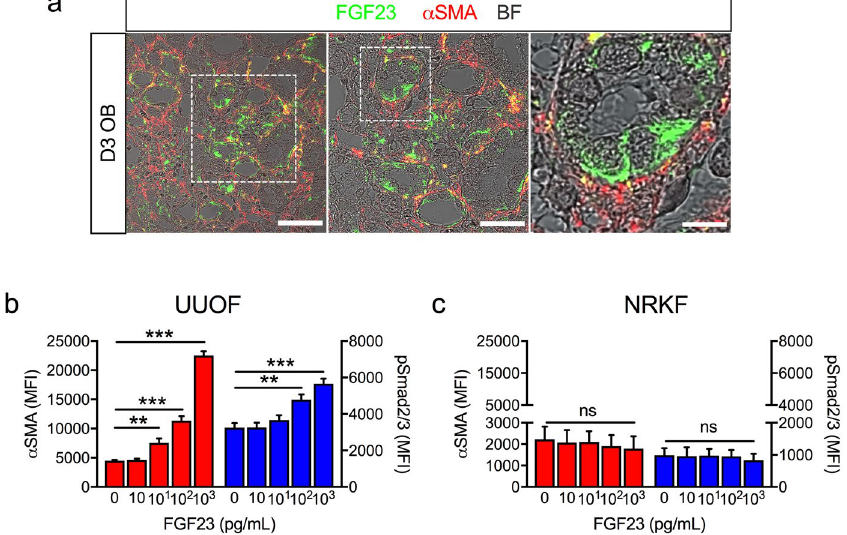
Figure 5. FGF23 stimulates renal fibroblast activation. ( a ) Representative immunofluorescent staining of FGF23 (green) and α SMA (red) in D3 OB kidney sections using brightfield (BF) confocal microscopy. Boxed region is enlarged in adjacent panels. Scale bars = 50, 25, 10 μ m left to right. ( b , c ) Quantitative flow cytometric analysis of FGF23 dose-related changes in α SMA (red) and phosphorylated Smad2/3 (blue) staining (mean fluorescence intensity, MFI) in UUOF ( b ) and NRKF ( c ) after 48 h treatment (n = 4 independent experiments). Data are shown as mean ± SD and represent at least three independent experiments with similar results. ** P < 0.01; *** P < 0.001; ns, not significant. P-values were determined in ( b,c ) by one-way ANOVA with Holm-Sidak multiple comparisons